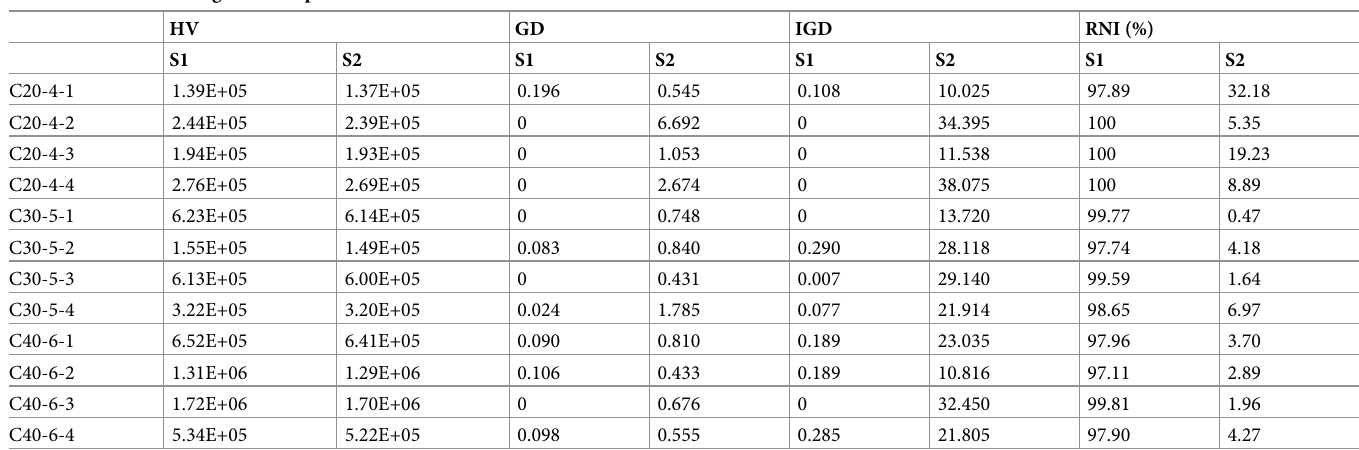
Table 4. Effects of strategies on the performance indicators.